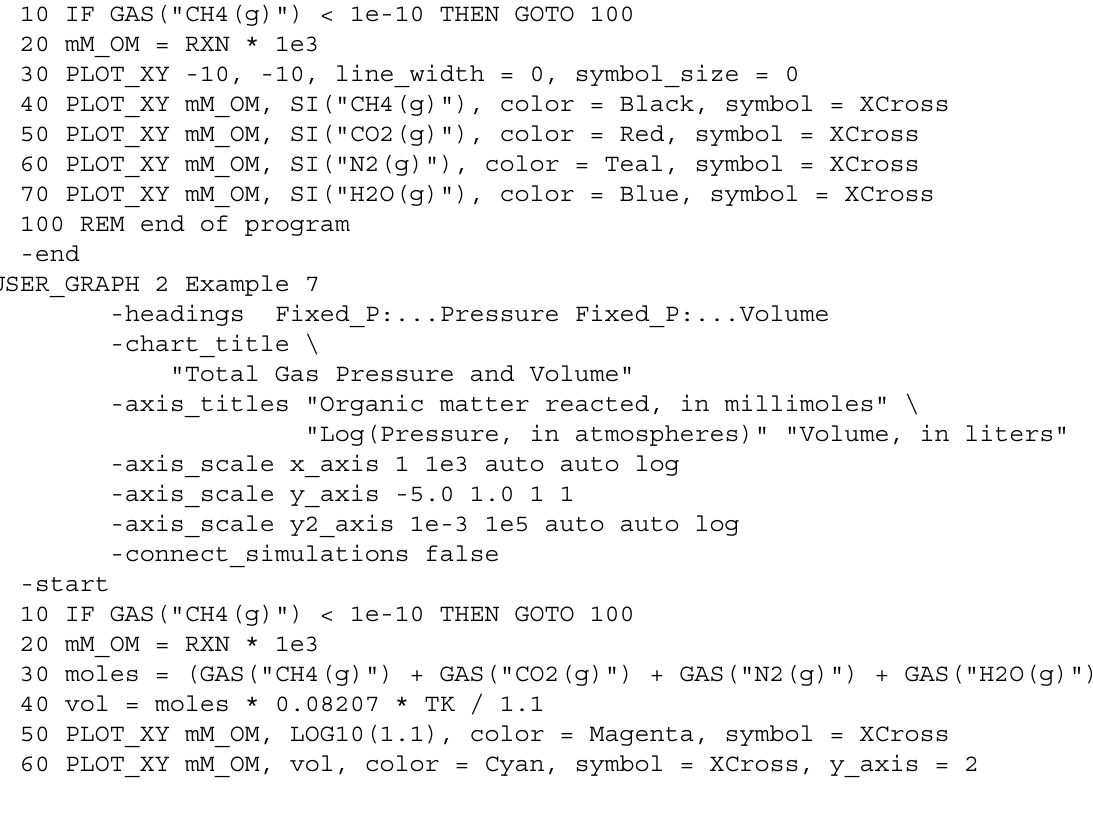
-headings Fixed_Pressure: CH4 CO2 N2 H2O